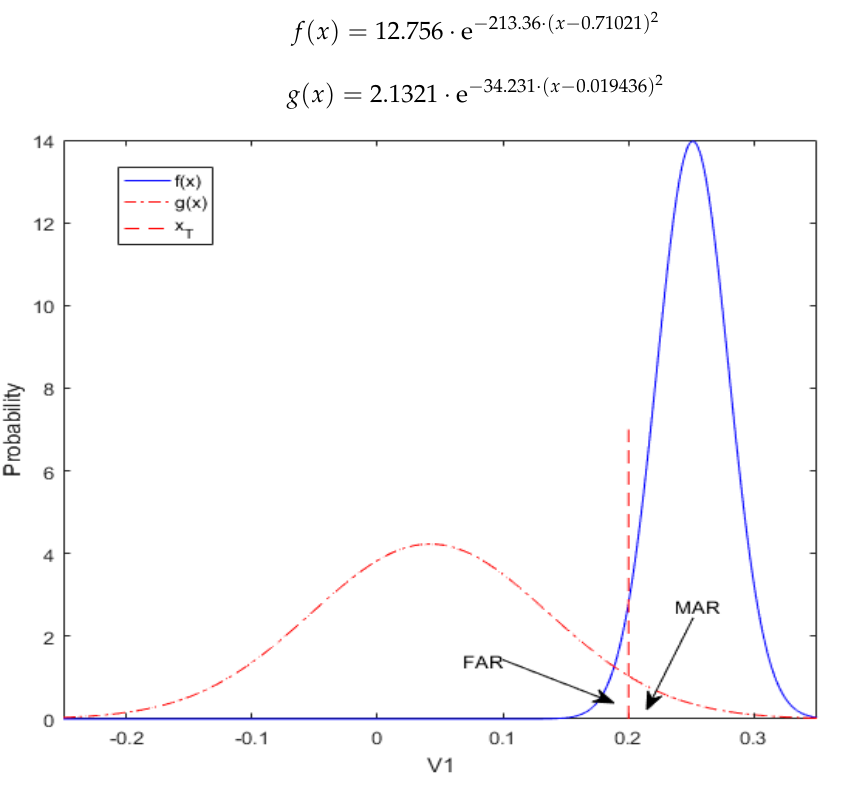
Figure 10. Process probability density curves of V1.